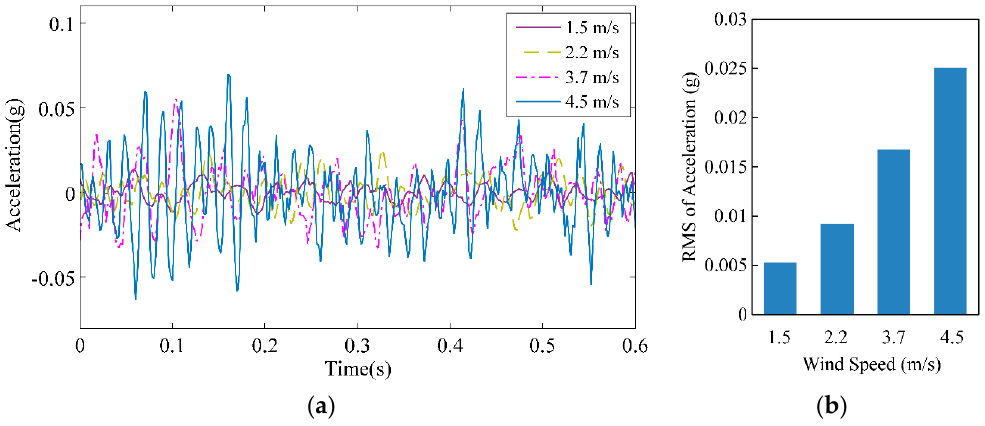
Figure 11. Acceleration responses of the conductor. ( a ) Vertical acceleration of the conductor; ( b ) root mean square (RMS) of the acceleration.